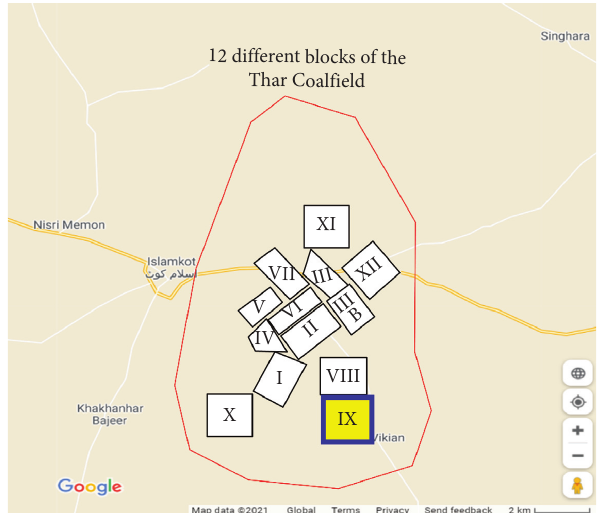
Figure 2: Location map of study area (Block-IX) of Thar Coalfield, Pakistan.